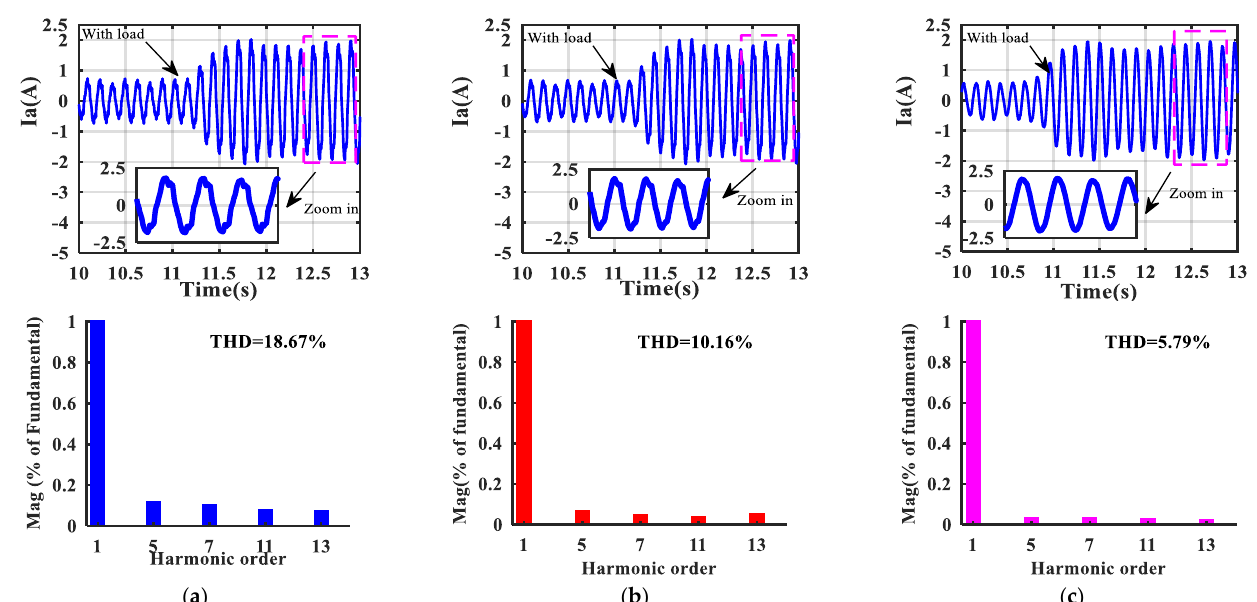
Figure 18. Simulation results of phase current and FFT analysis with load: ( a ) with a PI controller, ( b ) with a PIR controller and ( c ) with a Robust-TDOFR controller. Table 6. experimental results under the operation of sudden load.